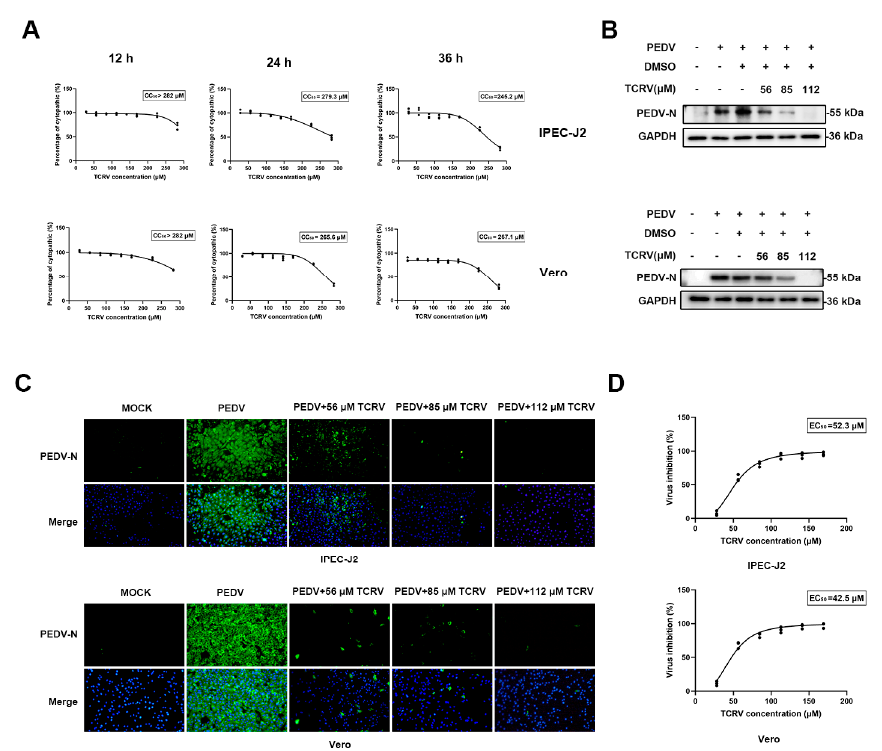
Figure 1. TCRV inhibits PEDV infection in Vero cells and IPEC cells. ( A ) Determination of the cytotoxicity of TCRV (28 µ M, 56 µ M, 85 µ M, 112 µ M, and 141 µ M) by the CCK-8 assay. ( B ) Vero cells and IPEC cells were mock − infected or infected with PEDV (MOI = 0.5 and 2.5). The expressions of PEDV N protein were assessed using Western blotting after TCRV treatment (56 µ M, 85 µ M, and 112 µ M). The results were presented as the ratio of the band intensities of the target protein to GAPDH. ( C ) The treatment of PEDV-infected cells with TCRV at concentrations of 56 µ M, 85 µ M, and 112 µ M. Cells were processed for immunofluorescence using antibodies against PEDV N protein and DAPI staining. ( D ) Dose-response curve for PEDV N protein inhibition by TCRV using immunofluorescence